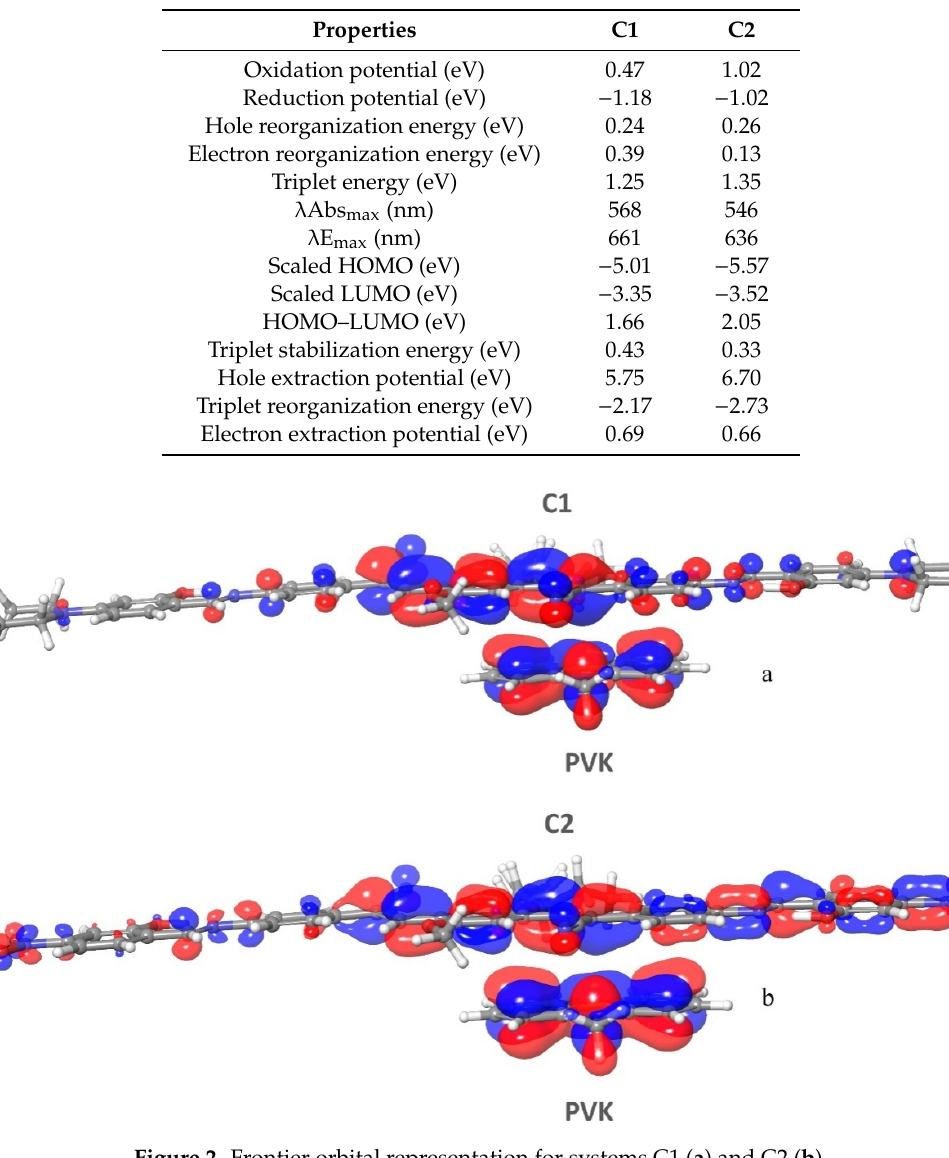
Figure 3. Energies of orbital levels of PS, PVK, C1, and C2. The arrows indicate possible electronic transitions. 2.3. Fabrication of a Red OLED An OLED device with the simplest architecture was fabricated with the 10 wt.% C1-PVK blend as an emissive layer. The structure of the device is reported in Section 3.3. In Figure 4, the current density–voltage characteristic of the device is reported. The turn-on voltage was approximately 3.5 V. The current density magnitude was quite low with respect to analogous devices reported in the literature [50], probably because the thickness of the layers was not optimized in the device structure. Moreover, since the measurements were performed in air soon after the evaporation, the degradation of the Ca/Al cathode could have affected the series resistance of the whole device, further limiting the current density.